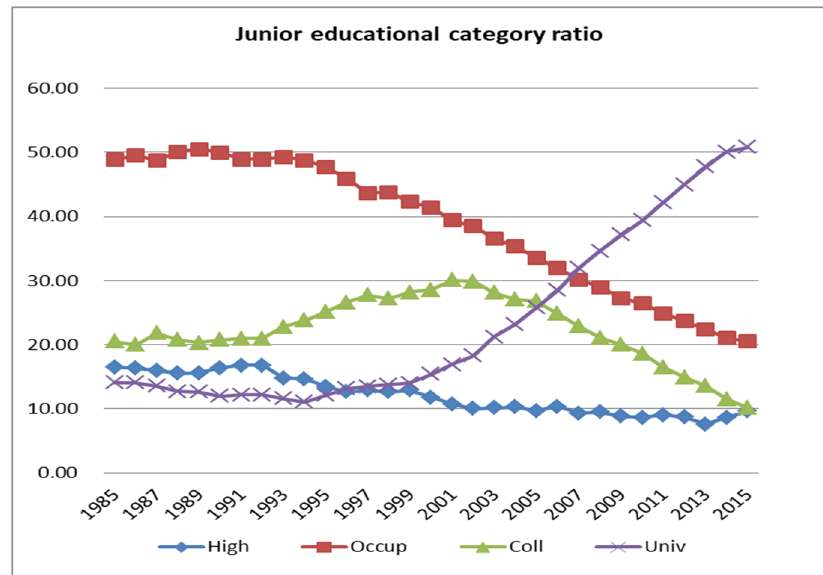
Figure 1. Junior educational category ratio. Source: MUS; author calculated.